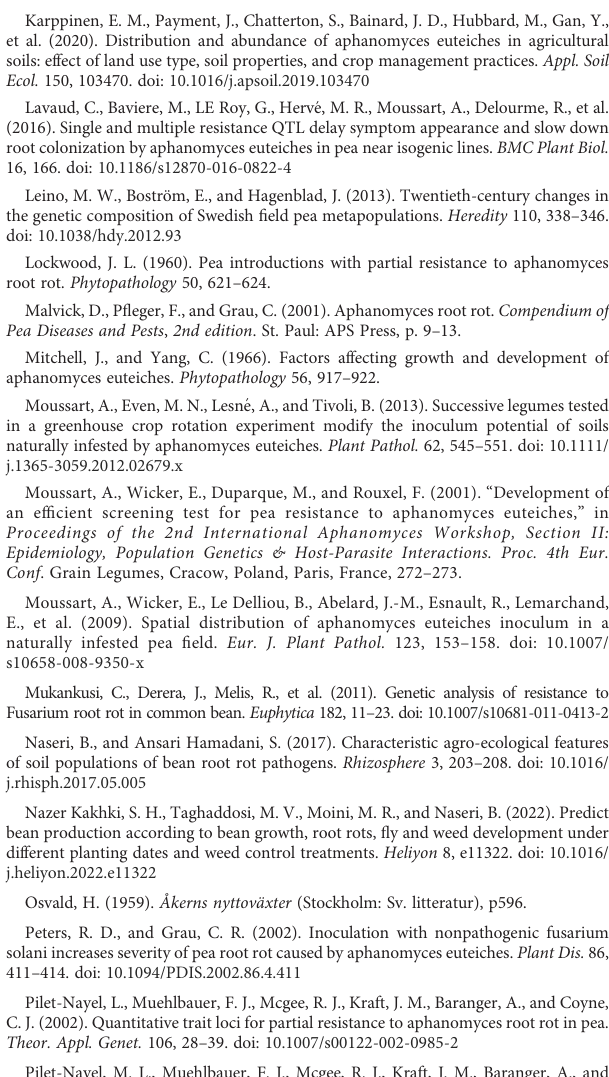
SUPPLEMENTARY TABLE 2 Combined Fisher LSD test results for growth chamber, greenhouse and fi eld